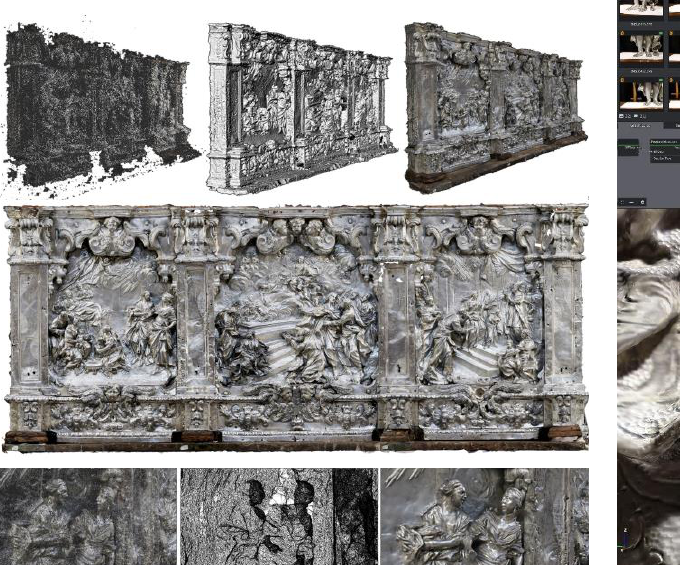
Figure 6 . Post - restoration photogrammetric acquisition of the frontal (structure and scenes, without caryatids): from point clouds to textured mesh and details.